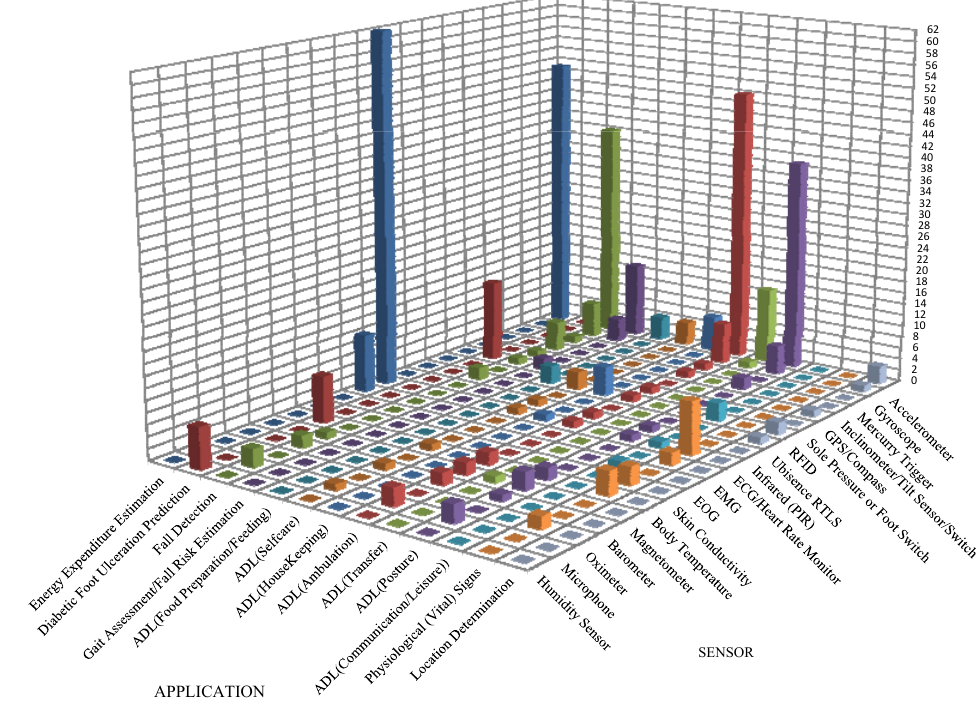
Figure 2. Distribution of research studies based on wearable sensors.